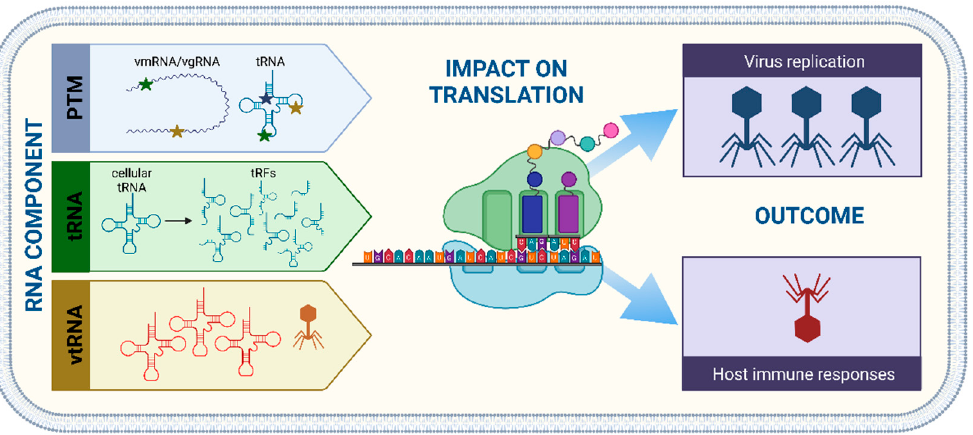
Figure 1. Schematic overview of selected RNA components utilized by viruses to further their replication and suppress host immune responses. Abbreviations: PTM = post-transcriptional chemical modification of ribonucleosides; tRNA = transfer RNA; tRF = tRNA-derived fragment; vgRNA, vmRNA, vtRNA = v irus-encoded g enomic, m essenger, or t ransfer RNA. Figure created with BioRender.